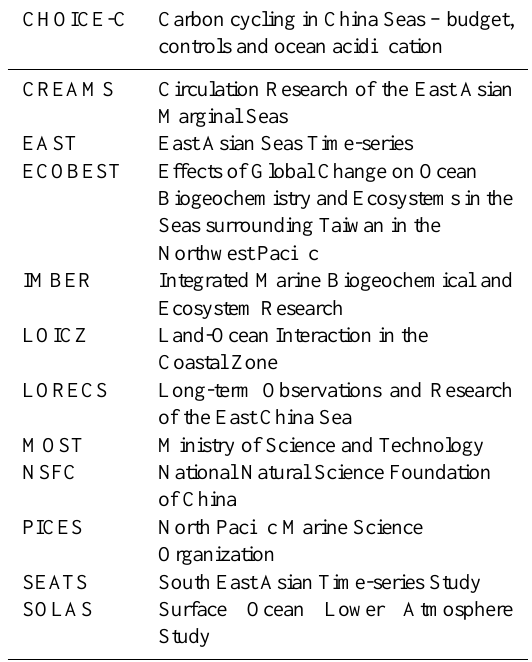
Table 1. List of acronyms and